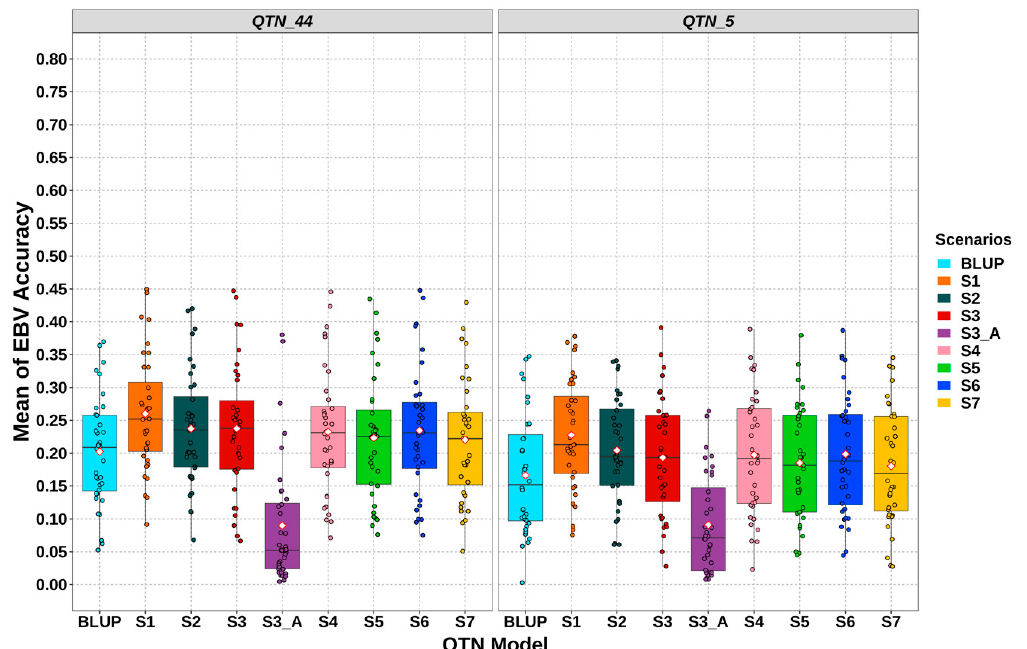
Figure 4. Accuracy of the estimated breeding values (EBVs) for each scenario within QTN models. “S” stands for scenario. QTN_5 stands for the QTN model with 5 QTNs per chromosome and QTN_44 stands for the QTN model with 44 QTNs per chromosome. The simulated rabbit genome comprised 20 chromosomes. Each dot stands for a simulation value within each scenario. White rhombus stands for the mean by scenario.